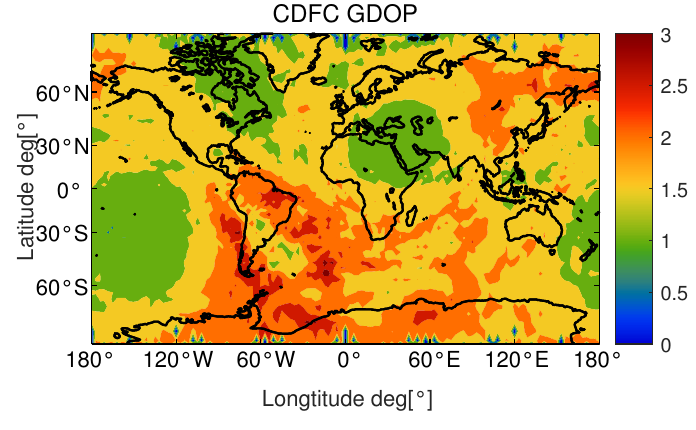
Figure 6. GDOP of